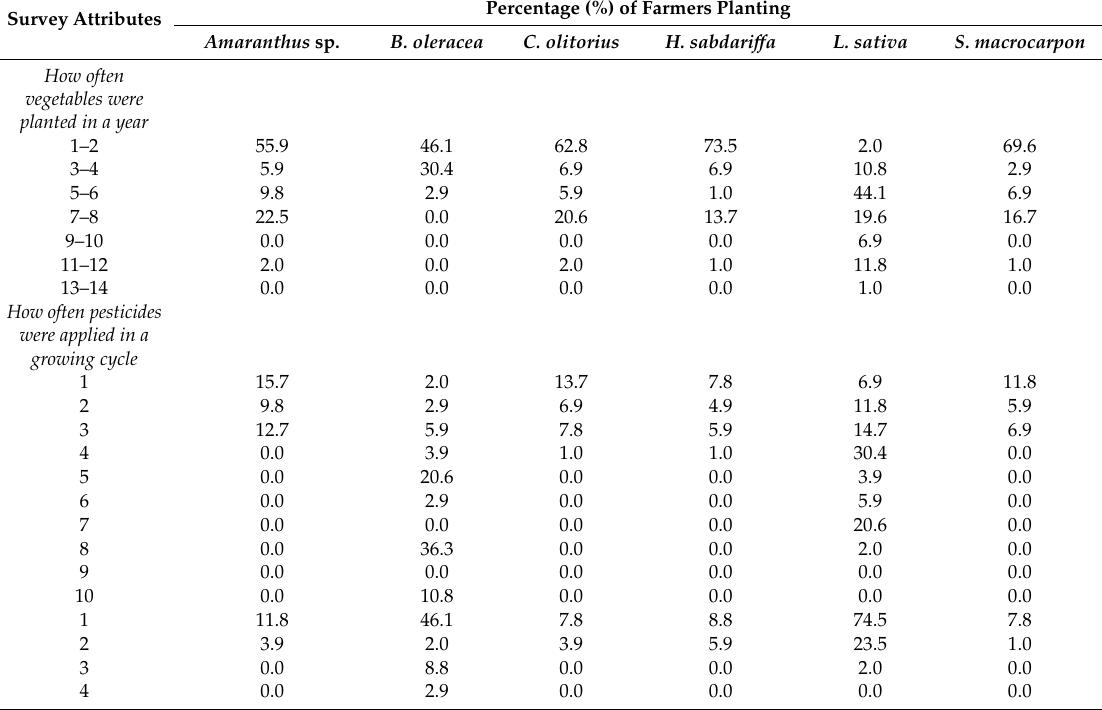
Table 3. Planting practices of participating vegetable farms in Accra,